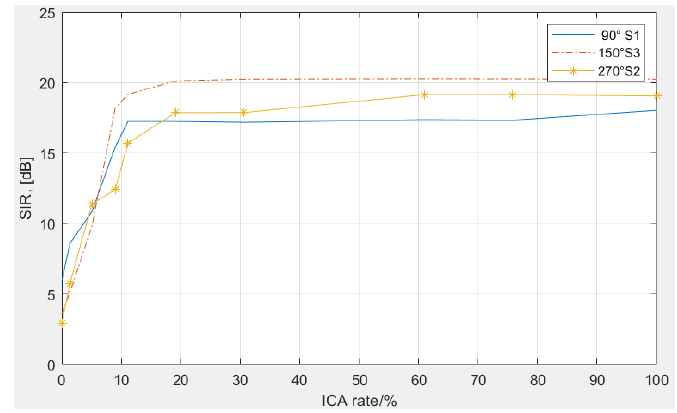
Figure 9. SIR improvement with modified separation under three sources in Room A.